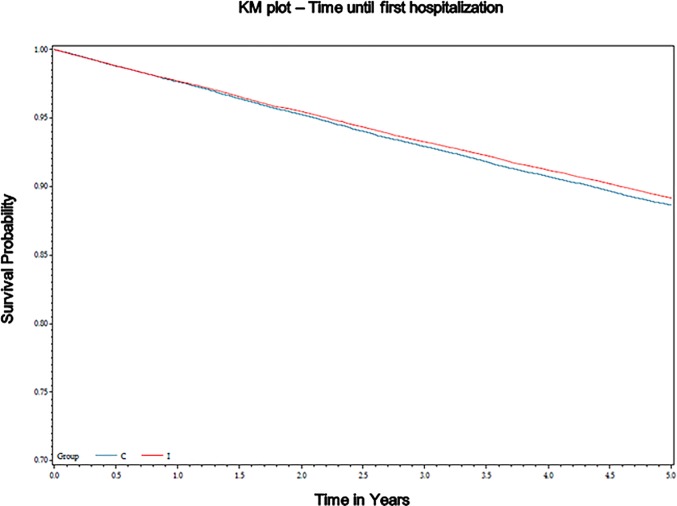
Time to first event for each outcome.Kaplan Meier curves represent the time to first event for each individual in the intervention and control communities. These graphs do not account for the clustered design of the study.